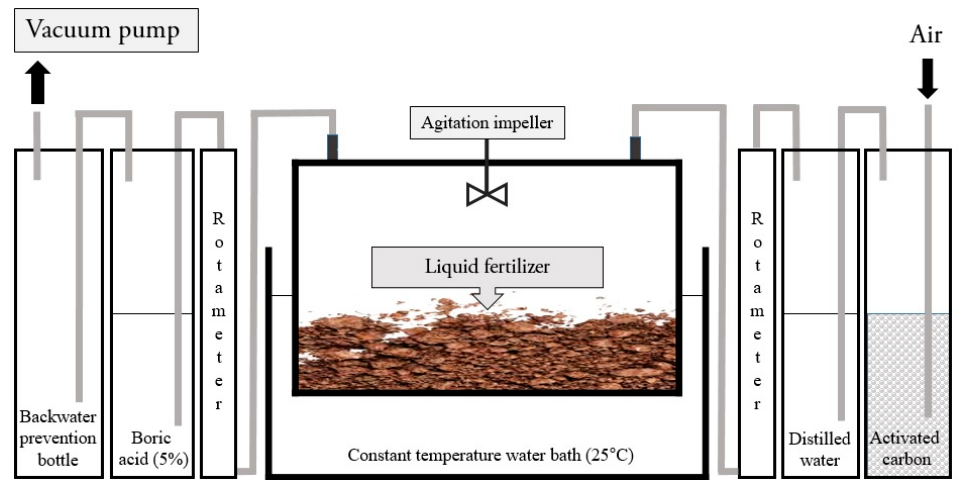
Figure 1. Schematic of dynamic chamber-capture system (DCS) with a constant temperature water bath.